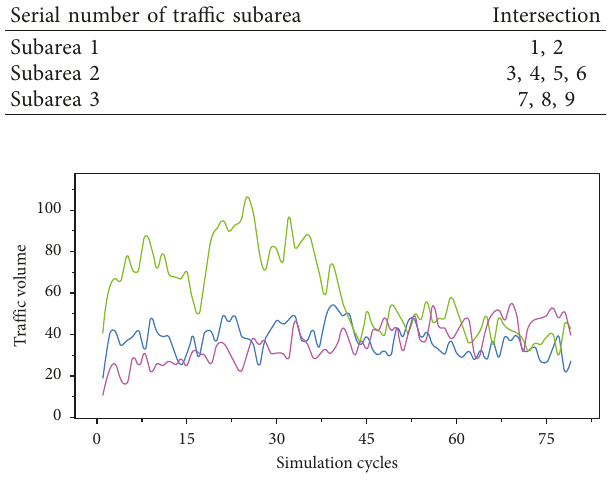
Figure 6: The study area in Huangpu District,